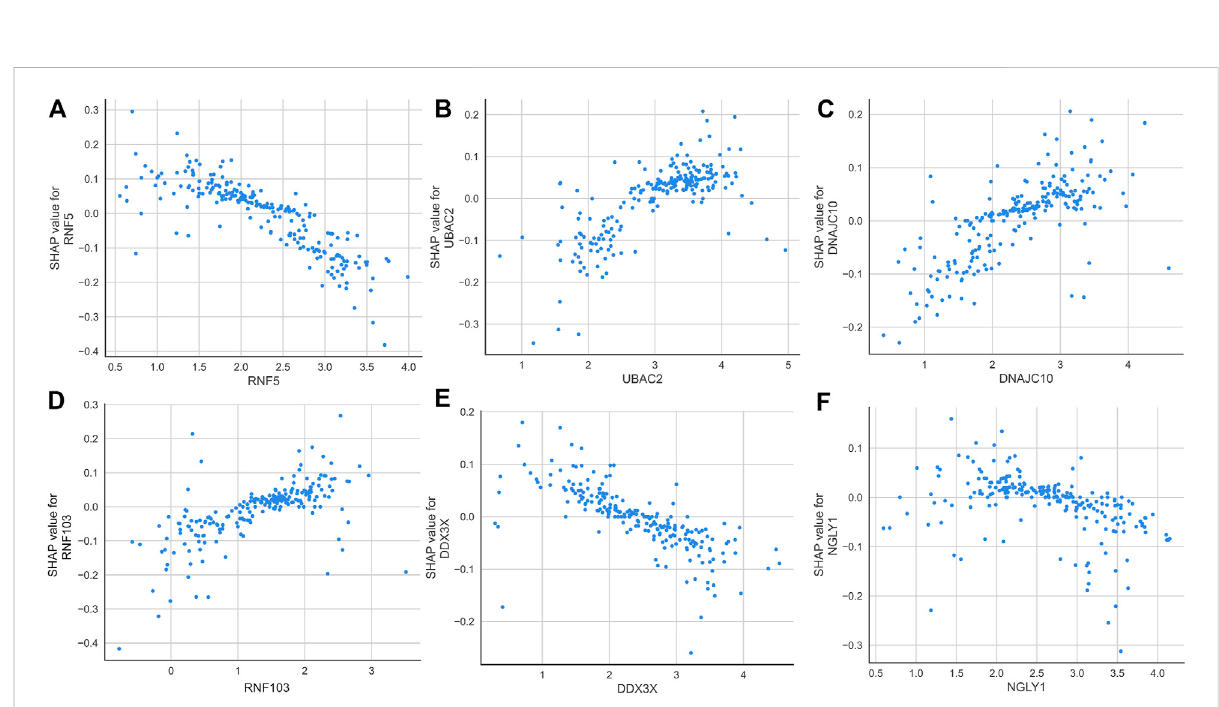
FIGURE 7 SHAP dependence plotof theSVMmodel, exhibiting theeffect ofRNF5 (A) , UBAC2 (B) , DNAJC10 (C) , RNF103 (D) ,DDX3X (E) ,and NGLY1 (F) on the prediction. SHAP values that exceed zero indicate an increased risk of